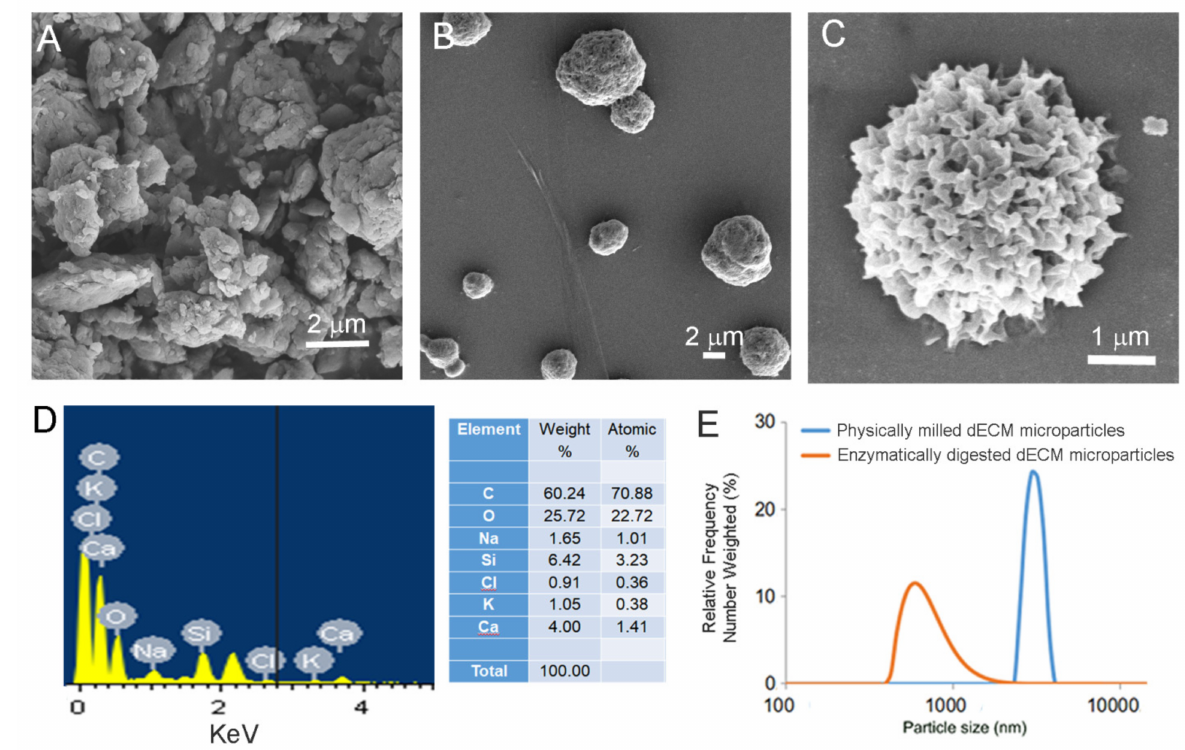
Figure 2. Physical characterization of dECM microparticles: ( A ) representative SEM image of physically processed dECM microparticles; ( B ) SEM image of enzymatically digested dECM microparticles; ( C ) SEM images of a EdECM microparticle showing petaloid-like architecture; ( D ) elemental analysis of EdECM microparticles demonstrating that its primarily composed of carbon and oxygen moieties confirming its ECM origin; and ( E ) hydrodynamic sizes of dECM microparticles via DLS